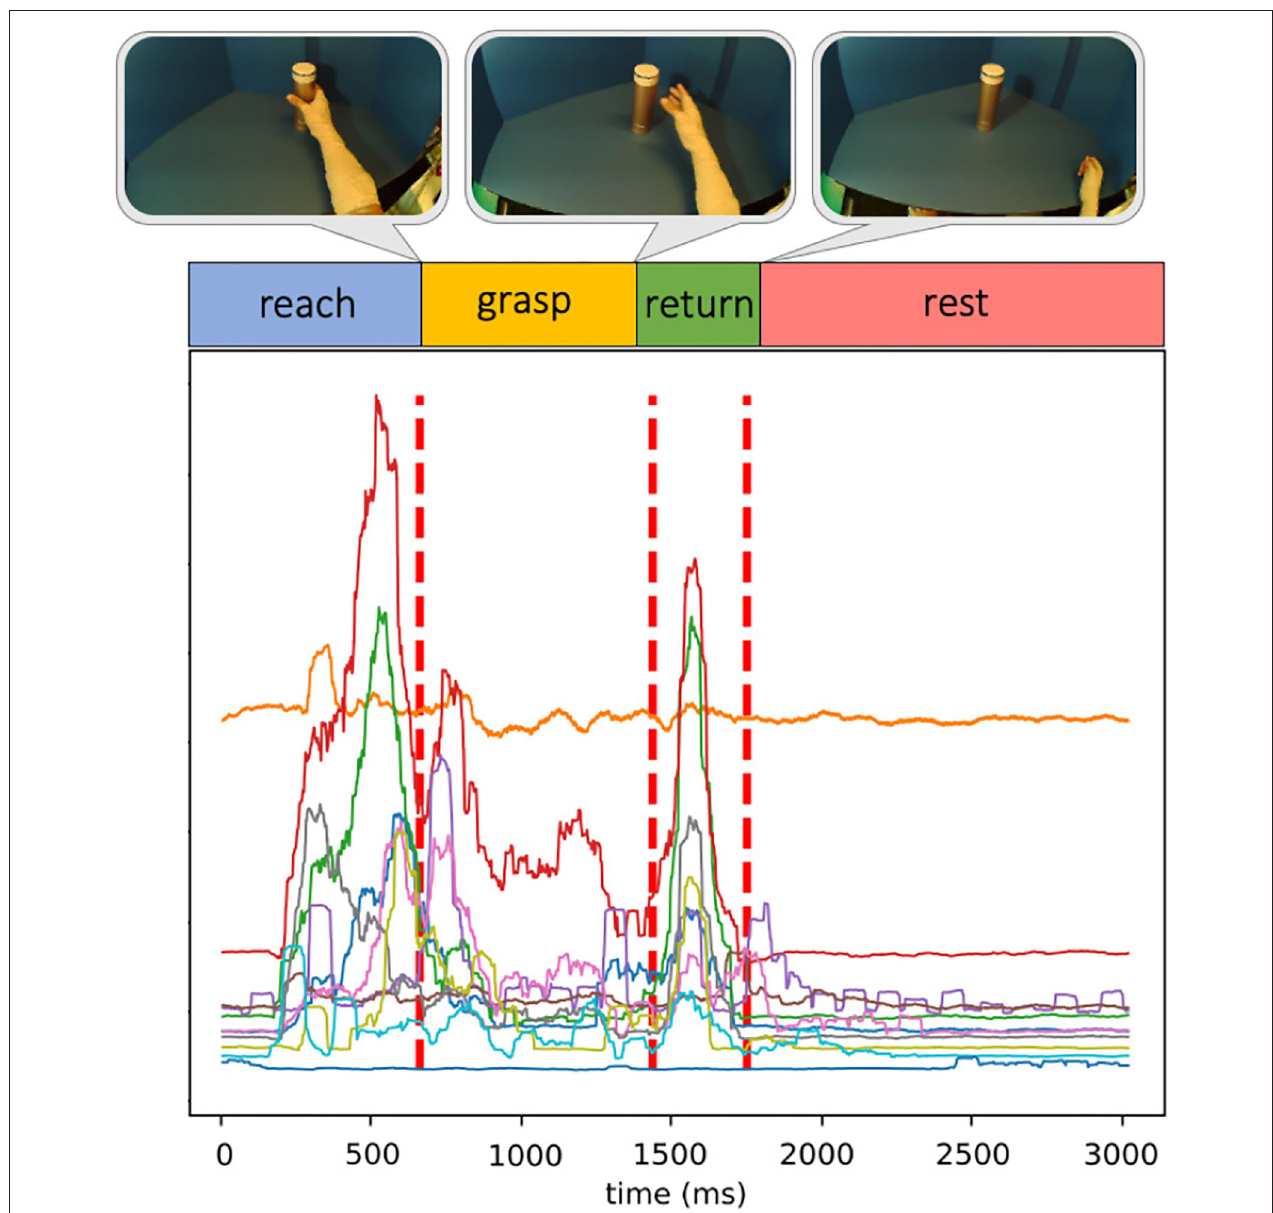
FIGURE 5 | An example of unsupervised segmentation of dynamic